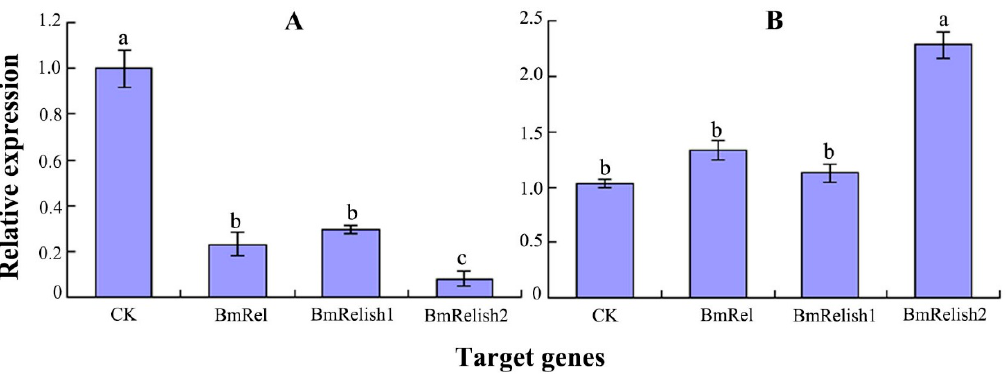
Figure 1. The gene expression levels of transcription factors after specific siRNA or DA treatments (( A ) The gene expression levels after respectively treated with specific siRNA for 24 h; ( B ) The gene expression levels after 8 h of DA treatment; CK: control). The different letters on the columns indicate the significant difference ( p < 0.05) by DMRT.